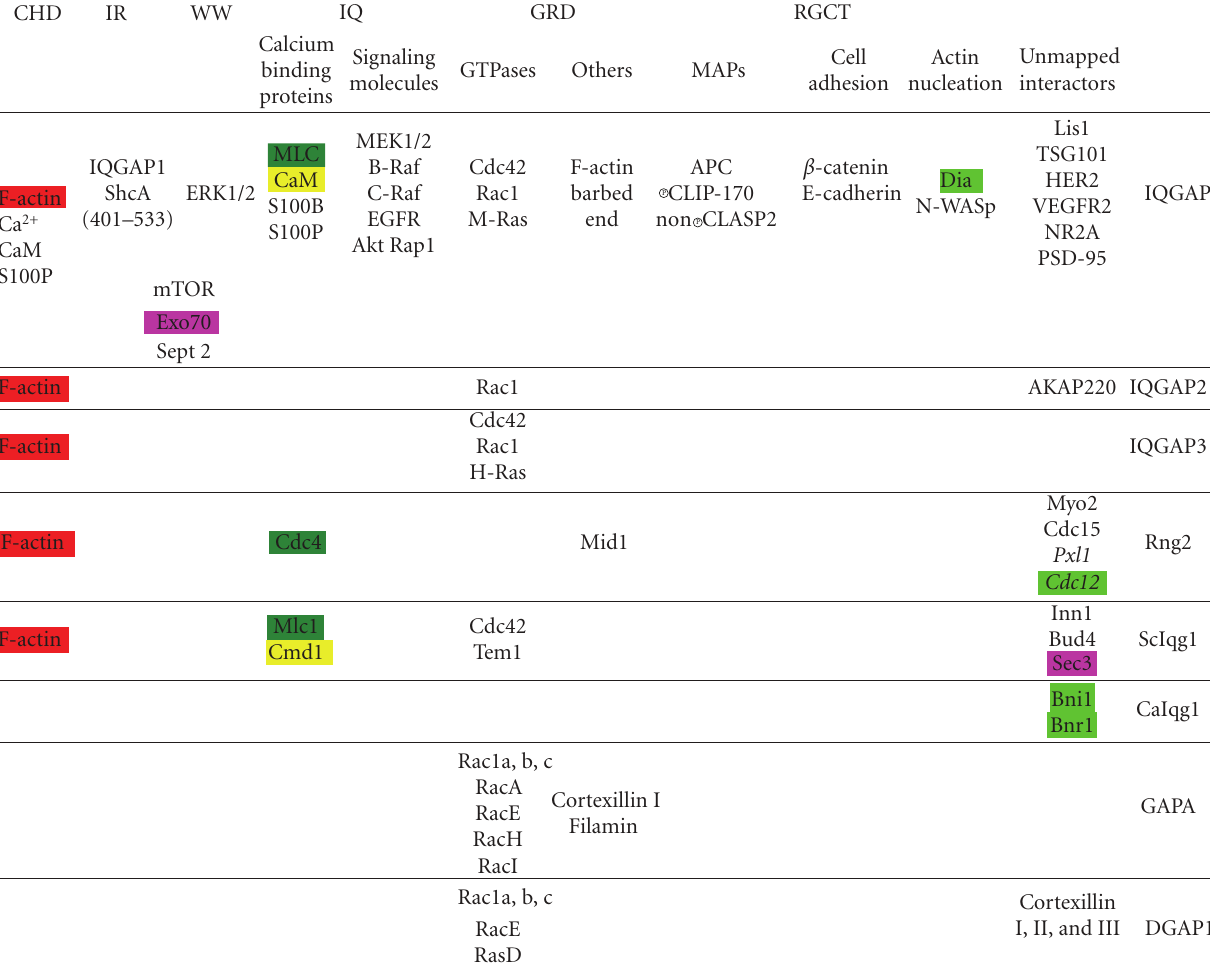
Table 1: Binding partners of IQGAPs. Binding partners of IQGAP family members are grouped by function and shown under the domain required for interaction. Proteins that are known to interact, but the IQGAP domain required has not been determined are listed under unmapped interactions. Proteins in italics represent genetic interactions, while all others are physical interactions. To draw attention to sim- ilar binding partners, the exocyst components are highlighted purple, formins are highlighted bright green, myosin light chains are shown in dark green, and calmodulins are shown in yellow. F-actin highlighted in